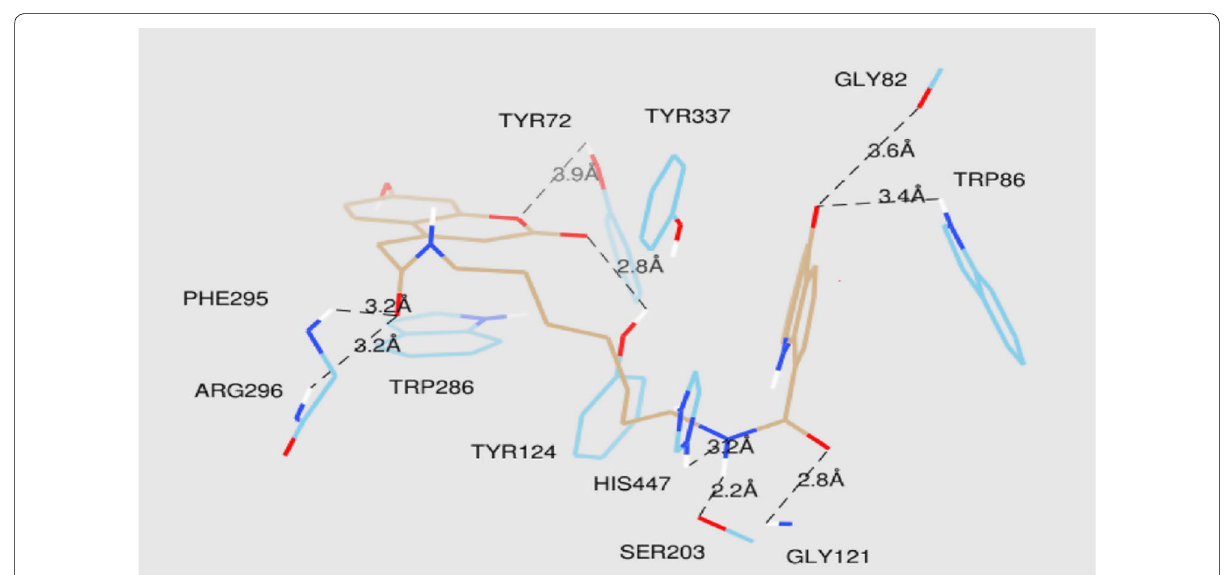
Fig. 47 Top-score docking pose of derivative C45a depicting its putative hydrogen bonds formed with amino acid residues in the active-site gorge of hAChE